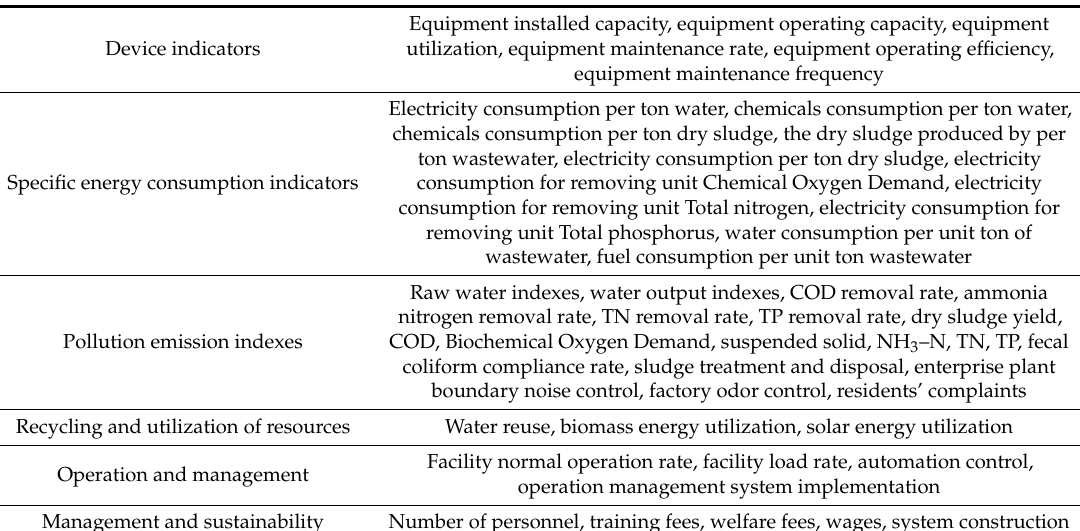
Table 3. Evaluation indexes of unit energy consumption of wastewater treatment